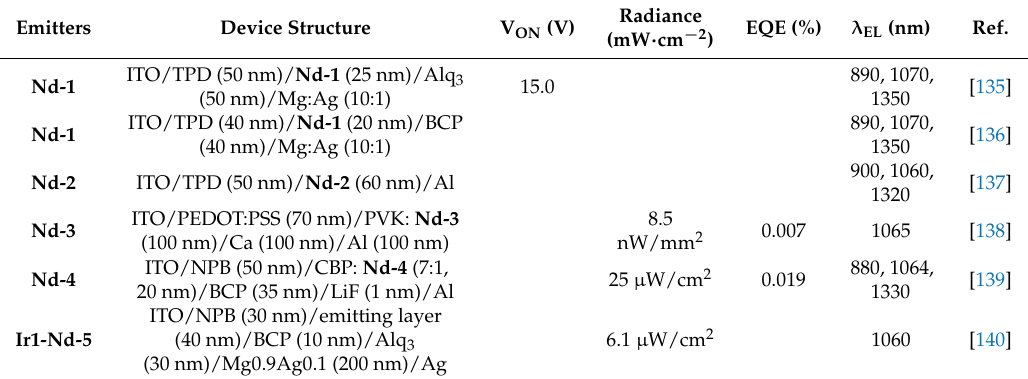
Figure 9. Nd-based near-infrared (NIR) emitters for light-emitting diodes. Table 6. Summary of electroluminescent properties of organic light-emitting diodes (OLEDs) fabricated with